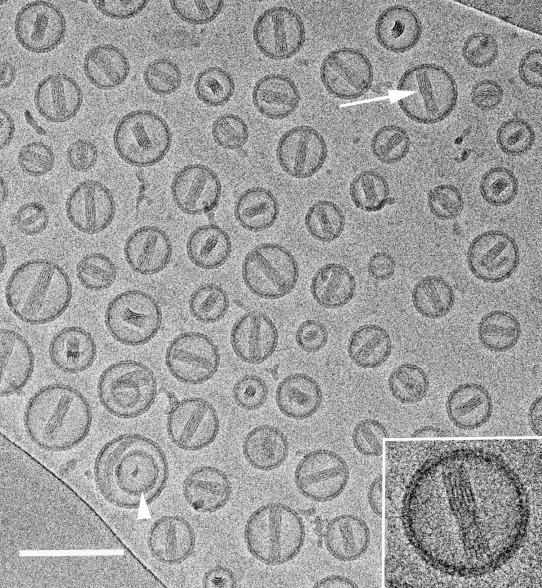
Figure 2. A cryo-TEM image of Doxil ® . The arrow points to a doxorubicin crystal encapsulated inside a single-membrane liposome. The same particle is shown at a higher magnification in the inset. The arrowhead points to an empty vesicle embedded in another one. The scale bar corresponds to 100 nm.